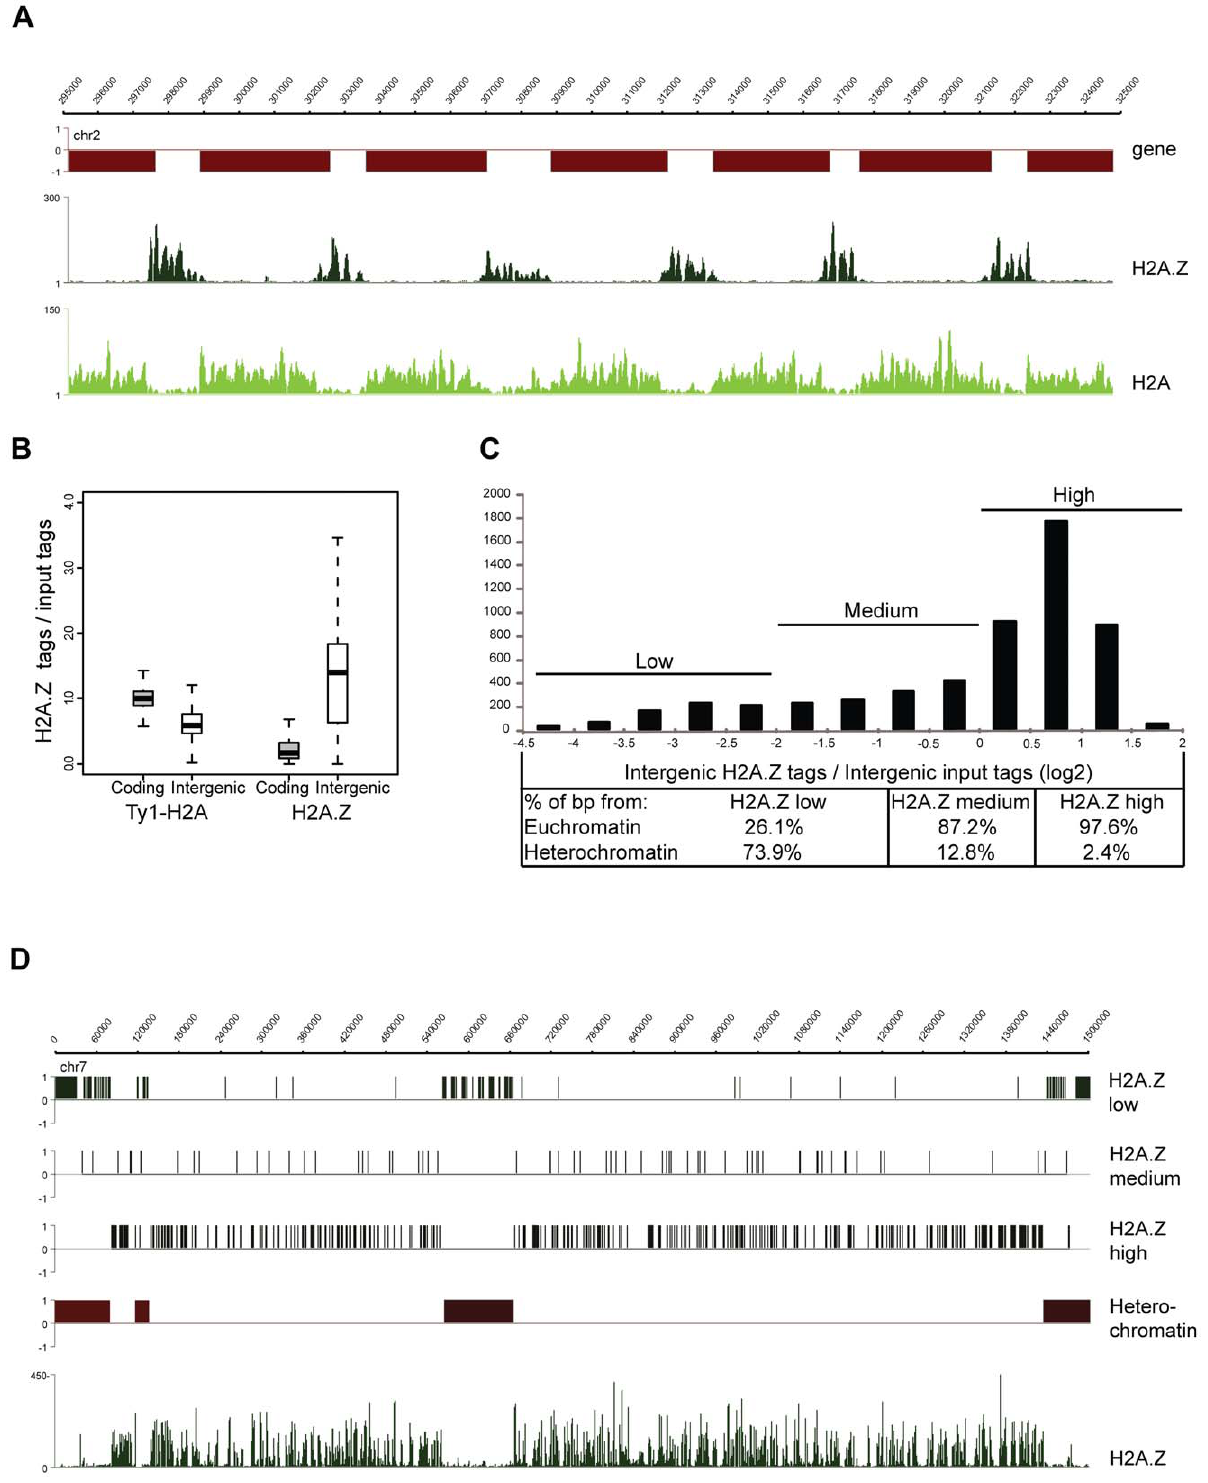
Figure 2. H2A.Z localizes to euchromatic intergenic regions. ( A ) Screenshots of the H2A.Z and H2A-Ty1 ChIP-seq coverage plots obtained from schizont stage parasites ( B ) Box-plot displaying the ratios of ChIP’ed vs mono-nucleosomal input DNA tag counts in every coding and intergenic regions of the P. falciparum genome. ( C ) Distribution of H2A.Z over mono-nucleosomal input tag counts in intergenic regions displayed as a histogram and their separation to three categories (low, medium, high). Table lists the percent of basepairs for each category located in heterochromatic vs. euchromatic domains of the P. falciparum epigenome. ( D ) Localization of intergenic regions with different H2A.Z occupancy (from C) across entire chromosome 7. H2A.Z coverage plot is included at the bottom.